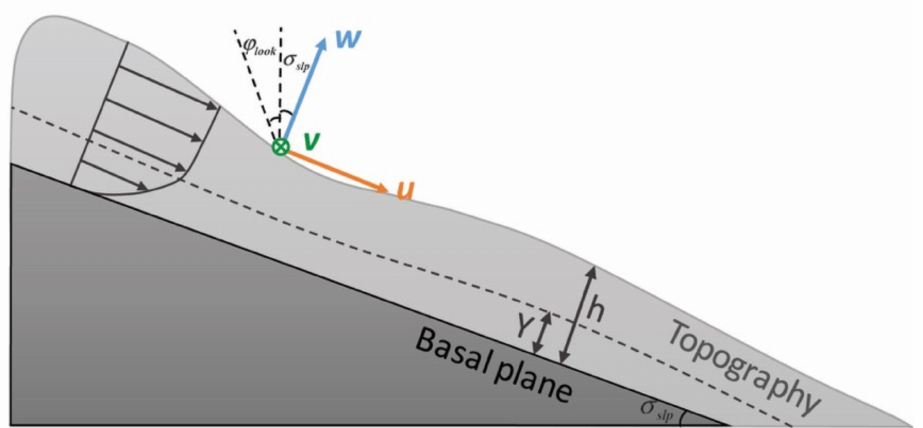
Figure 1. The configuration of landslide body. The landslide basal topography is modeled as a plane that defines the coordinates for the horizontal motion vector u and v of the slide and the vertical motion vector w . The thickness of landslide h goes through the lower yield zone and the overlying plug region: in the yield zone, the materials deform viscously with zero velocity at the basal plane; in the plug region, the materials move uniformly as a plug with no shear